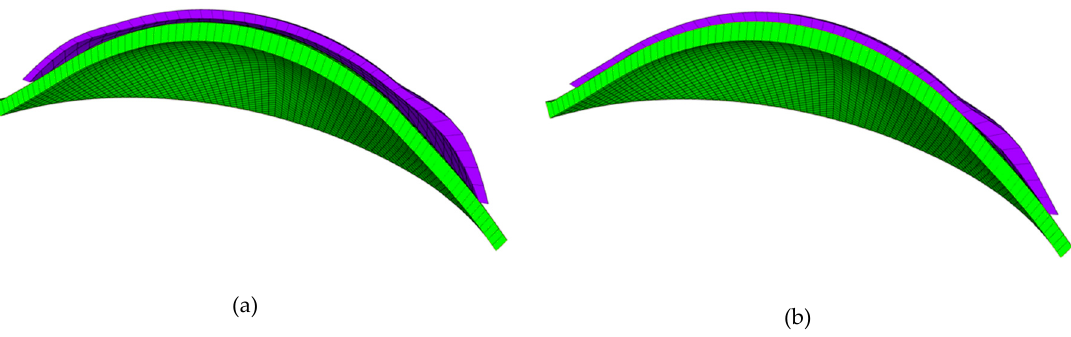
Figure 3. Finite element model of the contact lens (purple) and cornea (green). This model is shown before ( a ) and after ( b ) fitting.